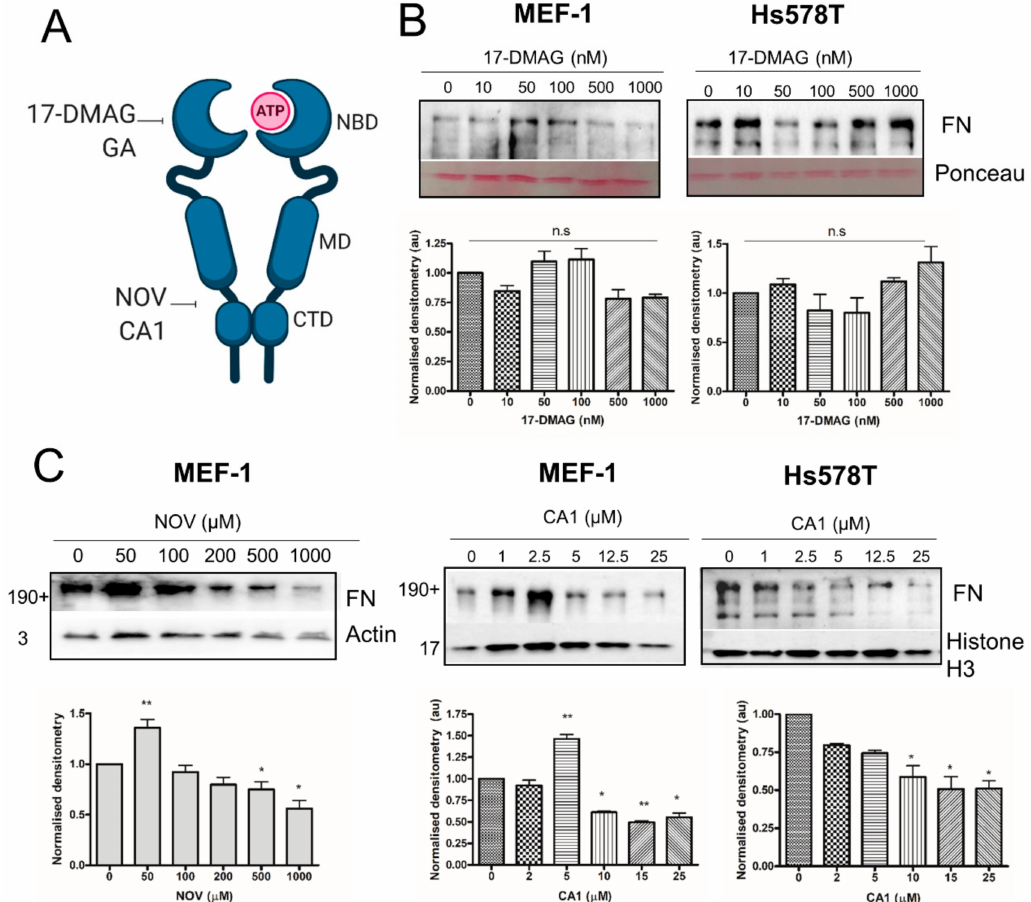
Figure 11. C-terminal HSP90 inhibitors reduce total FN levels in fibroblasts and breast cancer cells. ( A ) Schematic diagram showing the HSP90 domains targeted by inhibitors (NBD: N-terminal nucleotide-binding domain; MD: middle domain; CTD: C-terminal domain). Treatment of MEF-1 and Hs578T breast carcinoma cell lines with increasing concentrations of the ( B ) N-terminal HSP90 inhibitor, 17-dimethylamino-ethylamino-17-demethoxydeldanamycin (17-DMAG) or ( C ) C-terminal HSP90 inhibitors, novobiocin (NOV) or coumermycin A1 (CA1). Levels of FN in whole cell